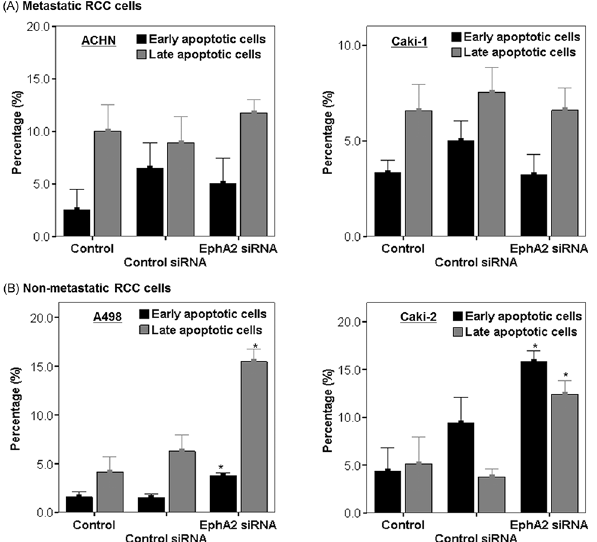
Fig 4. Evaluation of early or late apoptosis following EphA2 siRNA treatment in (A) metastatic RCC cell lines (ACHN and Caki-1) and (B) non-metastatic RCC cell lines (A498 and Caki-2). The proportion of apoptotic cells was compared among untreated cells (control), control siRNA treated cells and EphA2 siRNA treated cells at 48 hours following treatment in each cell line. * p < 0.05 vs. control and control siRNA treated groups. siRNA = small interfering RNA, RCC = renal cell